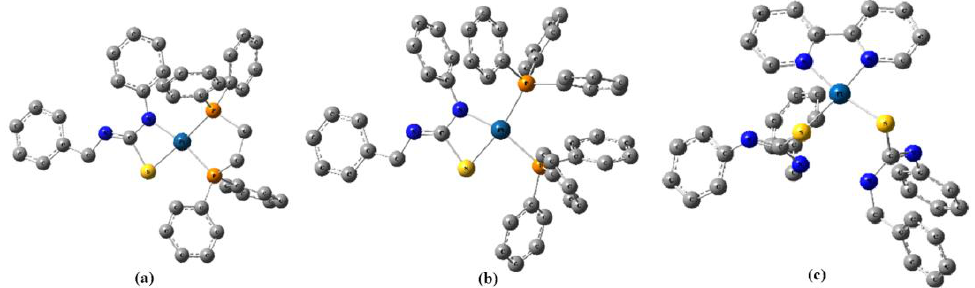
Figure 2. Optimized structures for ( a ) [Pt(BPT)(dppe)] ( 1 ), ( b ) [Pt(BPT)(PPh 3 ) 2 ] ( 5 ), ( c ) [Pt(BPT) 2 (Bipy)] ( 7 ). Hydrogen atoms were not shown for simplicity. The highest occupied molecular orbital (HOMO) and the lowest unoccupied mo- lecular orbital (LUMO) were calculated at the level of B3LYP/Def2-TZVP (Figure 3). It was found that the HOMO – LUMO gap for [Pt(BPT) 2 (Bipy)] ( 7 ) is less than the two other complexes. These results suggest that [Pt(BPT) 2 (Bipy)] ( 7 ) may be considered as a pho- tocatalyst with electron-hole activation in the solar energy range. Figure 3 shows that HOMO and LUMO are hybridized orbitals that contain Pt d-orbitals. P atoms have less electronegativity compared to S and N atoms. Therefore, unlike their contribution to LUMO, the P atoms do not contribute to HOMO charge density.